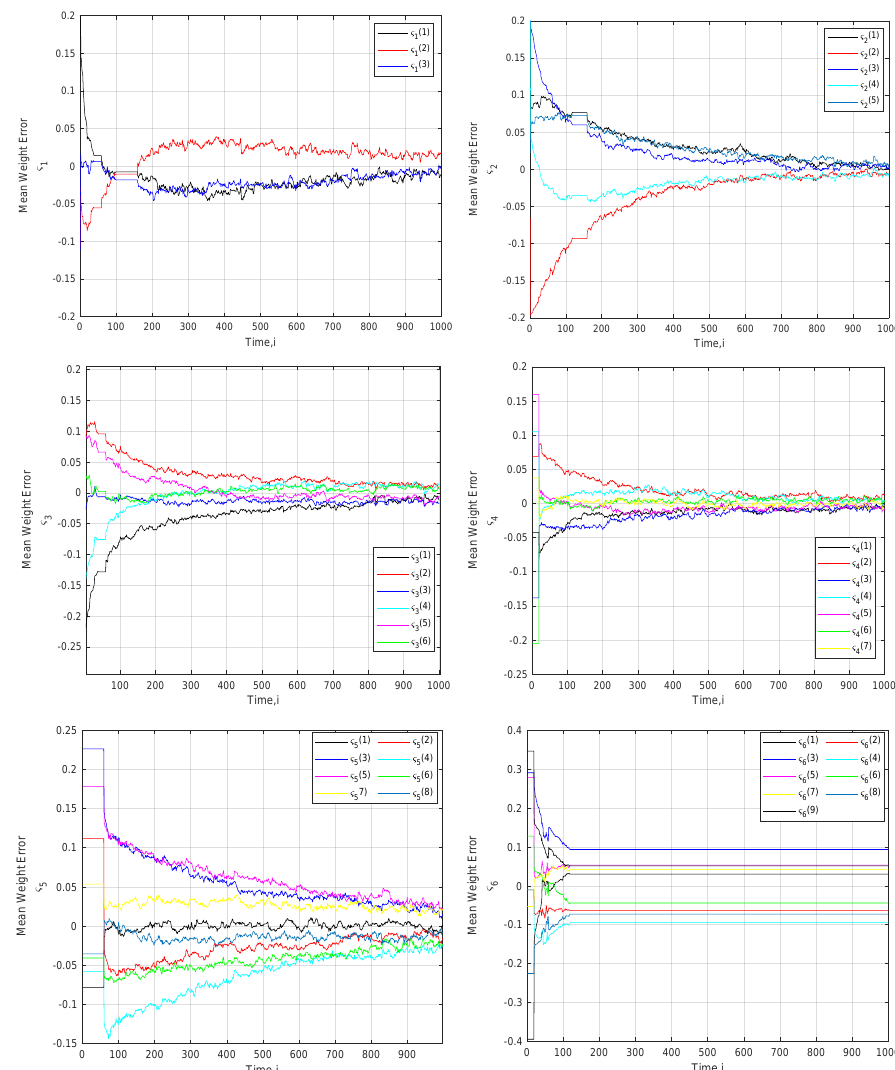
Figure 8. Mean Weight Error from the true parameters for the common vectors { ς j } 6